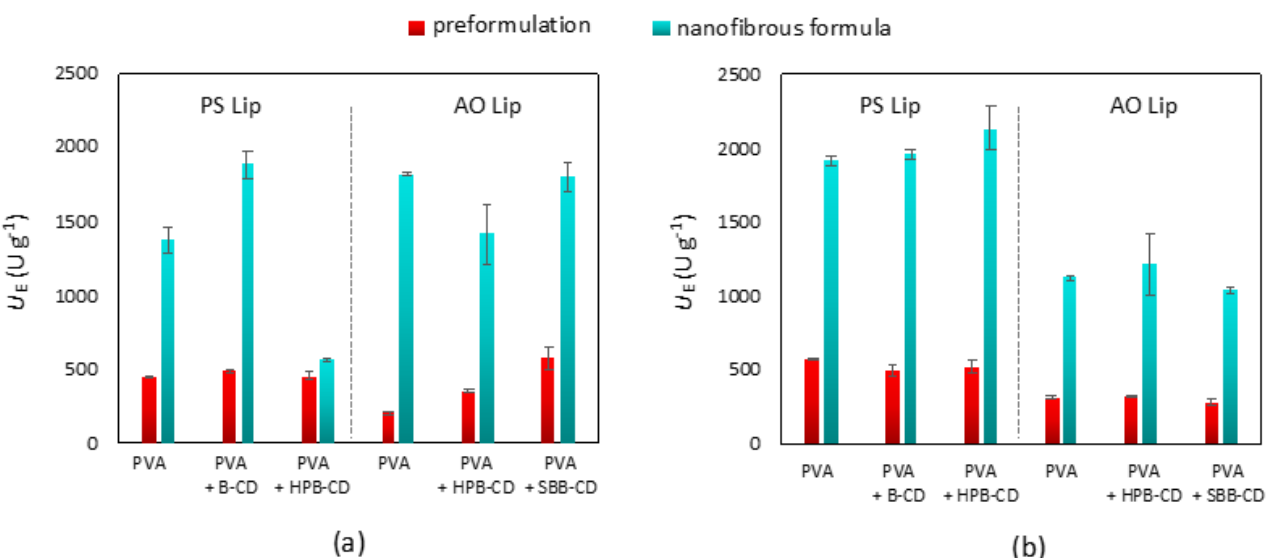
Figure 5. Comparison of the specific enzyme activity ( U E , U × g −1 ) of preformulated precursor (in red) and nanofibrous formulations (in aqua) of lipases from Burkholderia cepacia (PS Lip) and from Aspergillus oryzae (AO Lip) templated with different cyclodextrins in p -NPP hydrolysis after 1 h at 37.0 °C in ( a ) standard assay and ( b ) assay in FeSSIF (according to Section 2.8). To carry out the tests, 5 mg of the nanofibrous formulations that contain 10% ( w / w , relative to the sum mass of the fibers) lipase and CD in the appropriate lipase:CD mass ratio (PS Lip:CD = 1:1, AO Lip:CD = 1:3 ( w/w )) were dissolved in 5 mL of the appropriate buffer solution (Tris for standard assay and blank FeSSIF for the assay in FeSSIF). The same composition of solutions were prepared by dissolving Mowiol ® 18-88, lipase, and CD-s in the appropriate buffers (preformulated precursors); 150 μL of the resulting solutions were used to initiate the test reactions in 1.0 mL of standard assay and 1.0 mL of the assay in FeSSIF. B-CD: β-cyclodextrin, HPB-CD: 2-hydroxypropyl-β-cyclodextrin, SBB-CD: sulfobutylated-β-cyclodextrin.